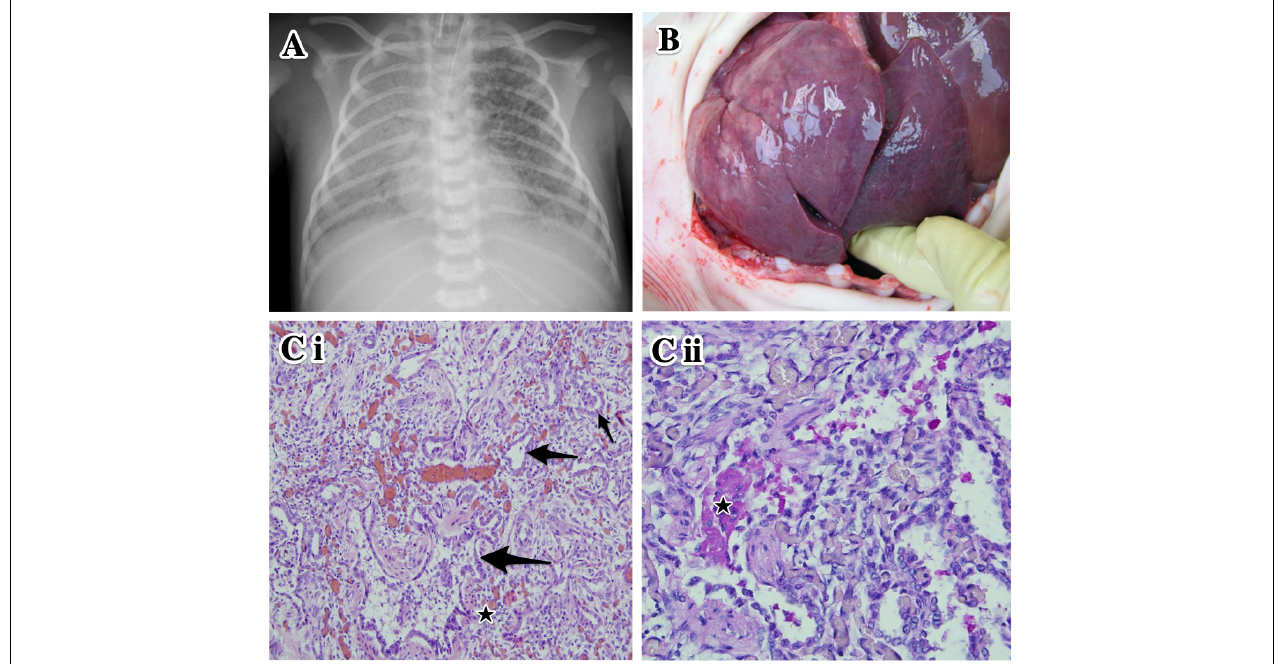
FIGURE 1 | Clinical data of the proband. (A) Plain chest X-ray at day 27 of life. High-frequency oscillatory ventilation. Asymmetrical transparency of right lung with signs of developing bronchopulmonary dysplasia. (B) Autopsy. Lung parenchyma is airless, pale violet color, tough and rigid to touch. (Ci) Histological examination of lung tissue. Marked variable interstitial widening (stars) and diffuse type II pneumocyte hyperplasia (arrows). Hematoxylin–eosin staining, original magnification 100 × . (Cii) Intra-alveolar glassy eosinophilic homogenous periodic acid-Schiff stain (PAS)-positive material (star). Original magnification 200 × .